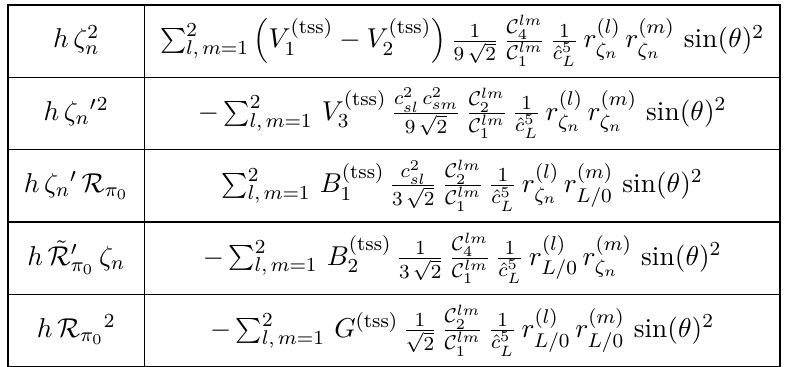
Table 4 . Squeezed shape for f TSS .